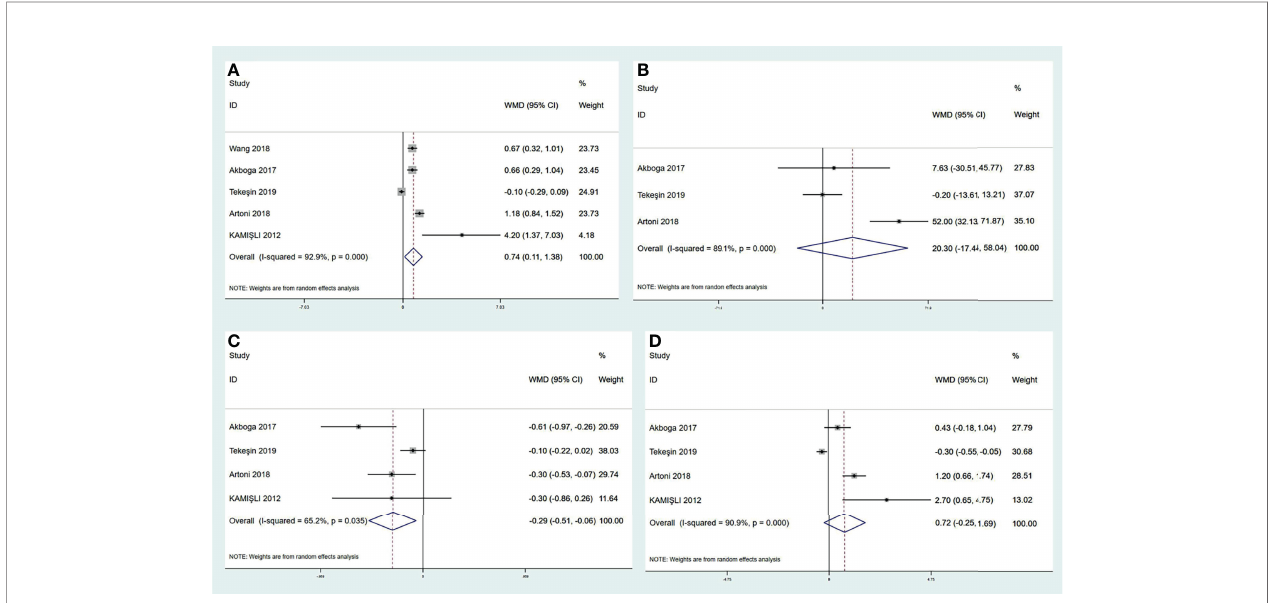
FIGURE 4 | Meta-analysis of in fl ammatory biomarkers in CVT versus healthy controls, including NLR (A) , PLR (B) , lymphocyte count (C) , and neutrophil count (D) . CVT, cerebral venous thrombosis; NLR, neutrophil-to-lymphocyte ratio; PLR, platelet-to-lymphocyte